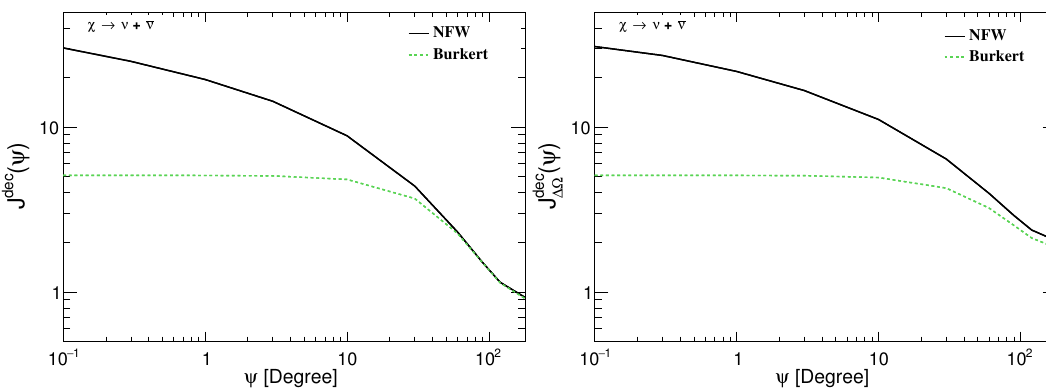
Figure 3. Line of sight integral for dark matter decay, J dec ( ), (see eq. (2.9)) vs. and the average value of J dec ( ) over solid angle (cid:1)(cid:10), i.e., J dec ( ) (see eq. (2.10)) for the decay process (cid:1)(cid:10) are shown in left and right panels respectively. In both the panels black solid and green dashed lines present the corresponding quantities for the NFW and the Burkert pro(cid:12)les respectively. We use the value of J dec (cid:1)(cid:10)